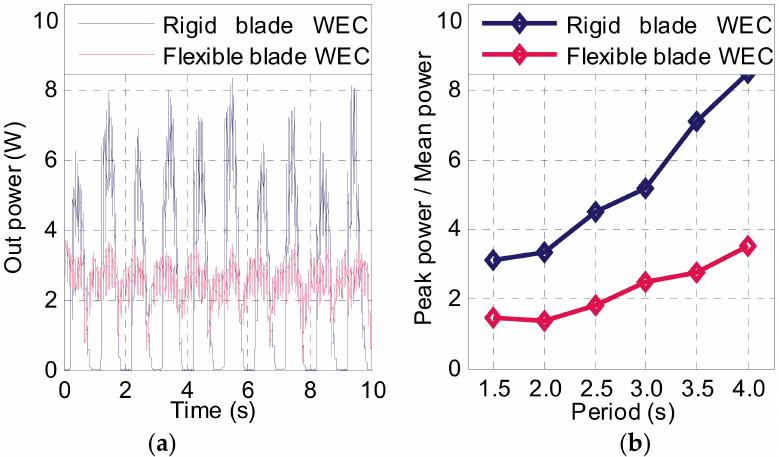
Figure 22. Comparison of rigid blade WEC and flexible blade WEC: ( a ) Instantaneous power curves; ( b ) Power